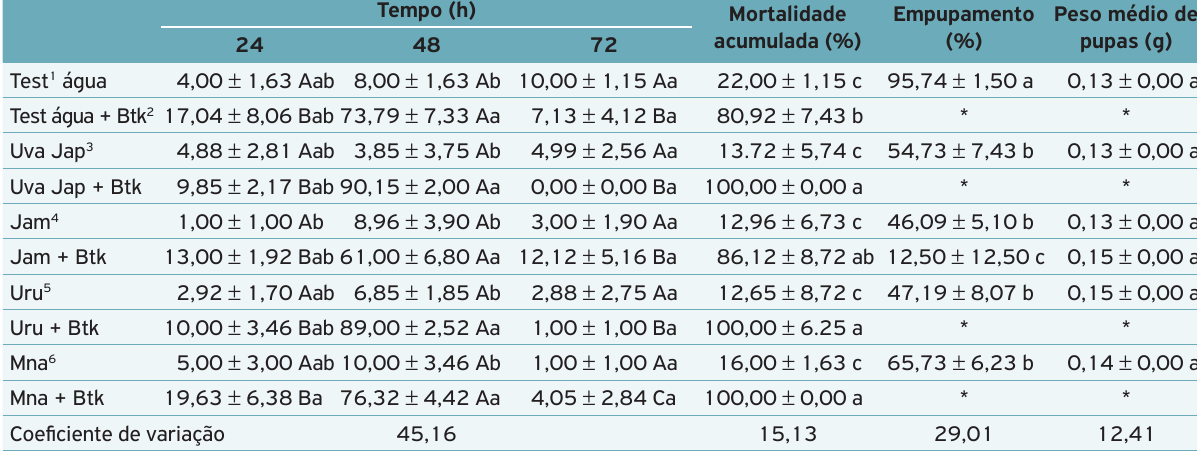
Tabela 1. Porcentagem média ( ± erro padrão) da mortalidade nos tempos de 24, 48, 72 horas e acumulada, porcentagem de empupamento e peso médio de pupas de Anticarsia gemmatalis tratadas com extratos vegetais aquosos (10%) e Bacillus thuringiensis subesp. kurstaki após incubação (30 ± 2ºC, 150 rotações por minuto, 2 horas) com e extratos vegetais aquosos (10%). Temperatura 26 ± 2ºC, 12 horas de fotofase e umidade relativa de 70 ±